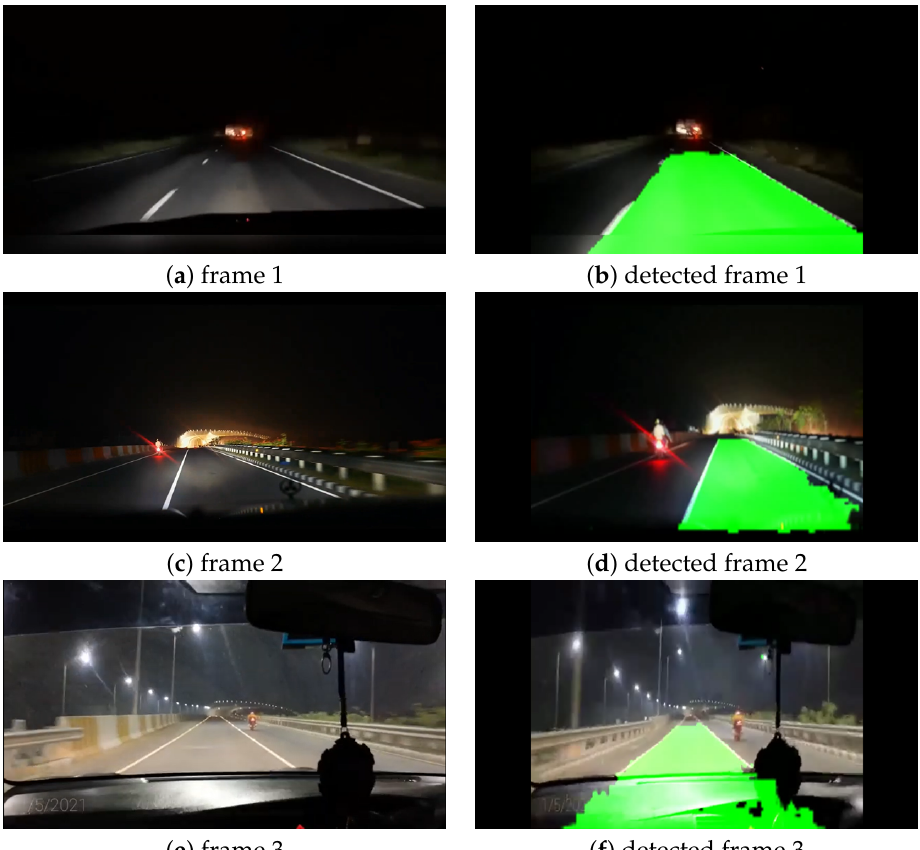
Figure 8. Visualization of lane detection on night condition. Defected Pavement and Occuladed Lane Line